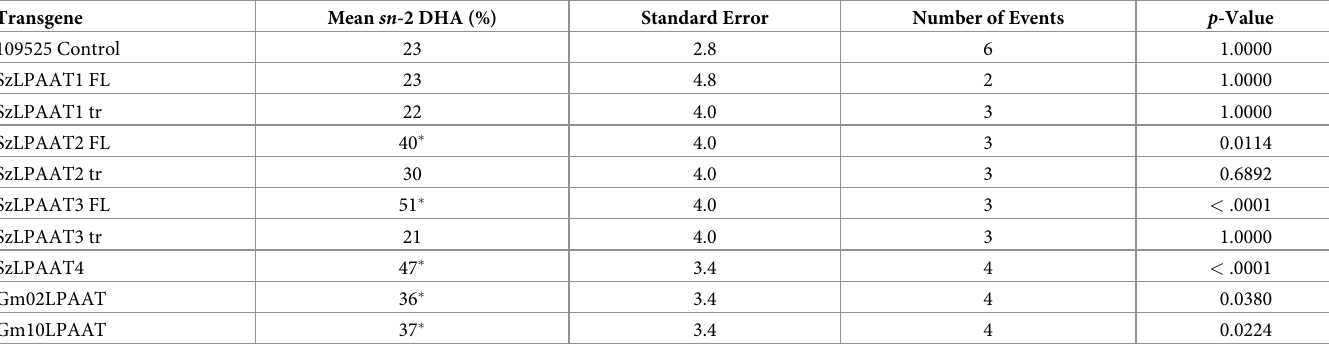
Table 1. Positional analysis of DHA in T 2 transgenic LPAAT seed TAG.